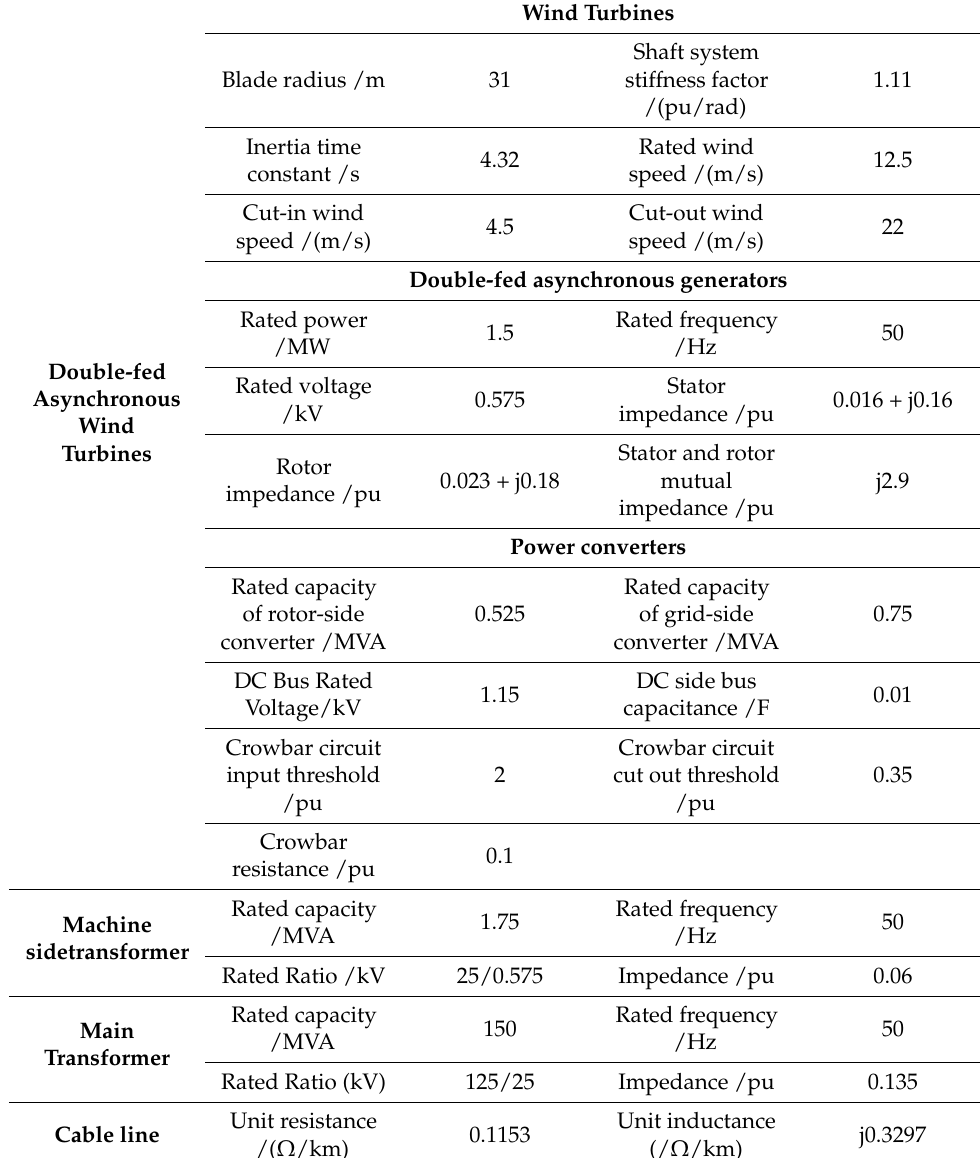
Table A1. Simulation